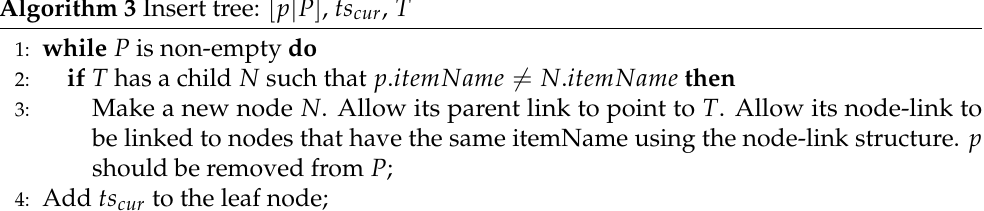
Algorithm 3 Insert tree: [ p | P ] , ts cur ,